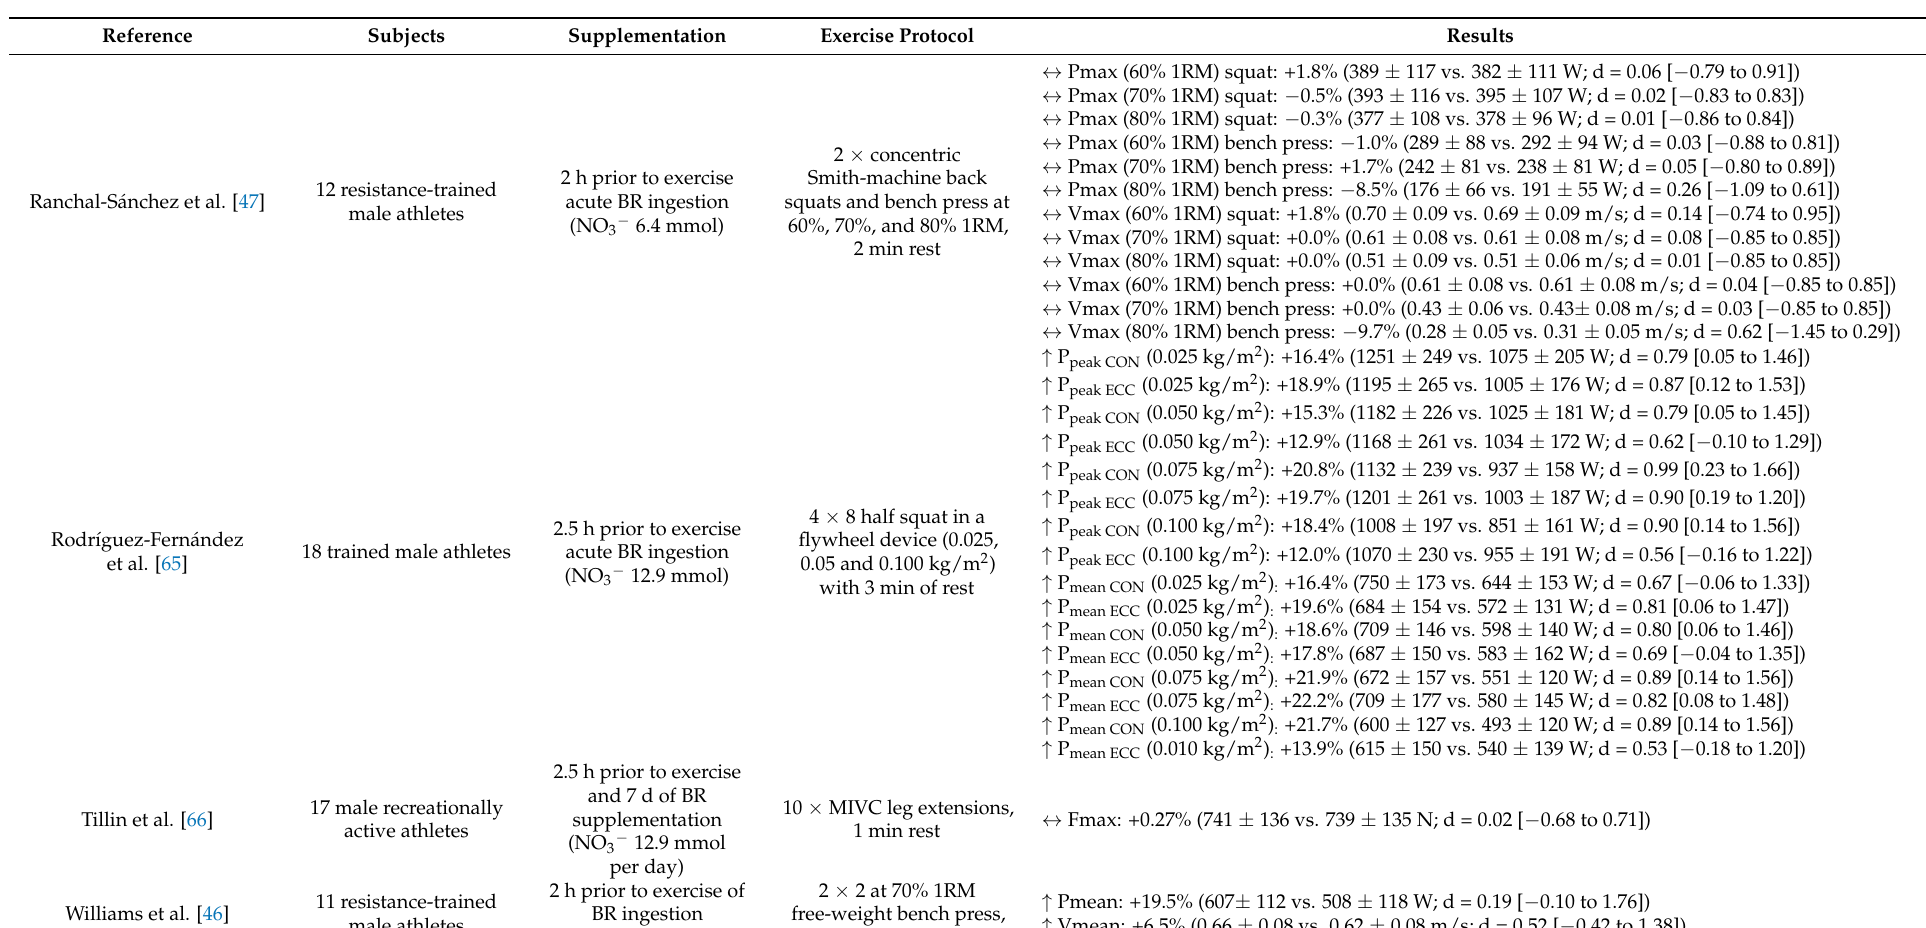
Table 3. Description of studies that have investigated the effects of NO 3 − supplementation on explosive resistance efforts in humans. There were 4 studies out of 10 that reported improved P peak in back squat [65], isokinetic knee flexion at 60 ◦ /s [40], isokinetic knee extension at 6.28 rad/s [37], and during free-weight bench press [46] as well as V mean of contraction during free-weight bench press exercise